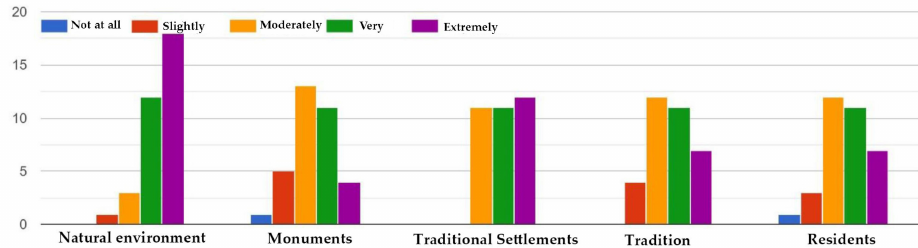
Figure 12. Bar diagram of the evaluation of the participants about Kythera’s natural environment, monuments, traditional settlements, tradition and